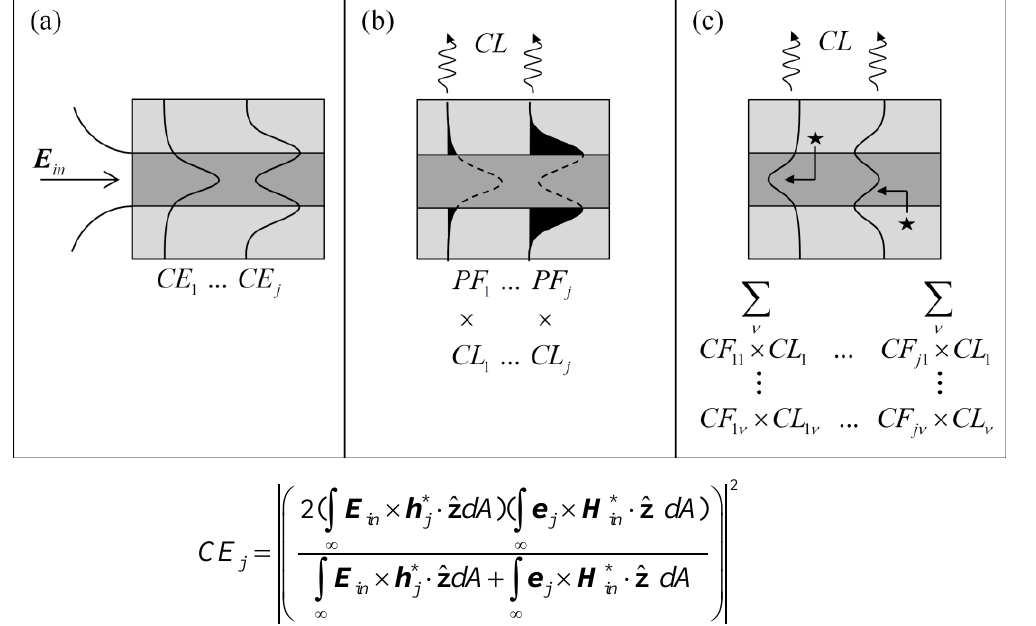
Figure 3. An overview of ( a ) the coupling of excitation light into different fiber core (dark grey) optical modes; ( b ) the power fractions of the optical modes (black shaded area) outside the solid core showing the confinement losses due to the dimensions of the core; ( c ) Raman scattering sites (stars), showing coupling of the Raman signal into different optical